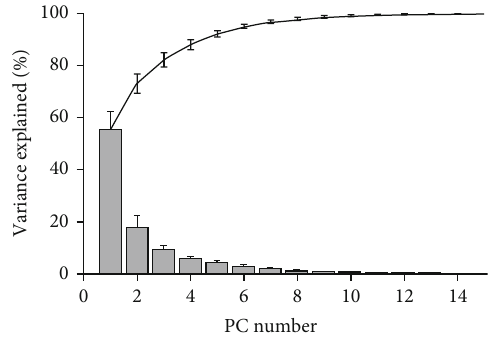
Figure 6: Information transmitted by PCs (subject mean and